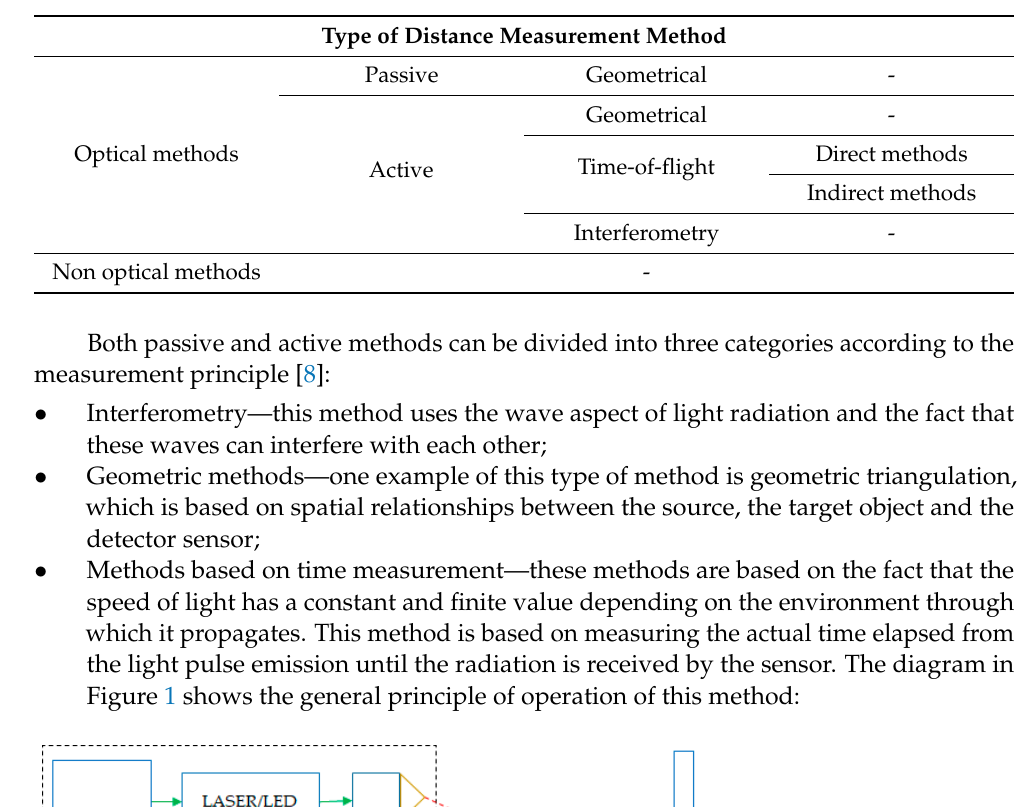
Table 1. Examples of methods used to determine distance.